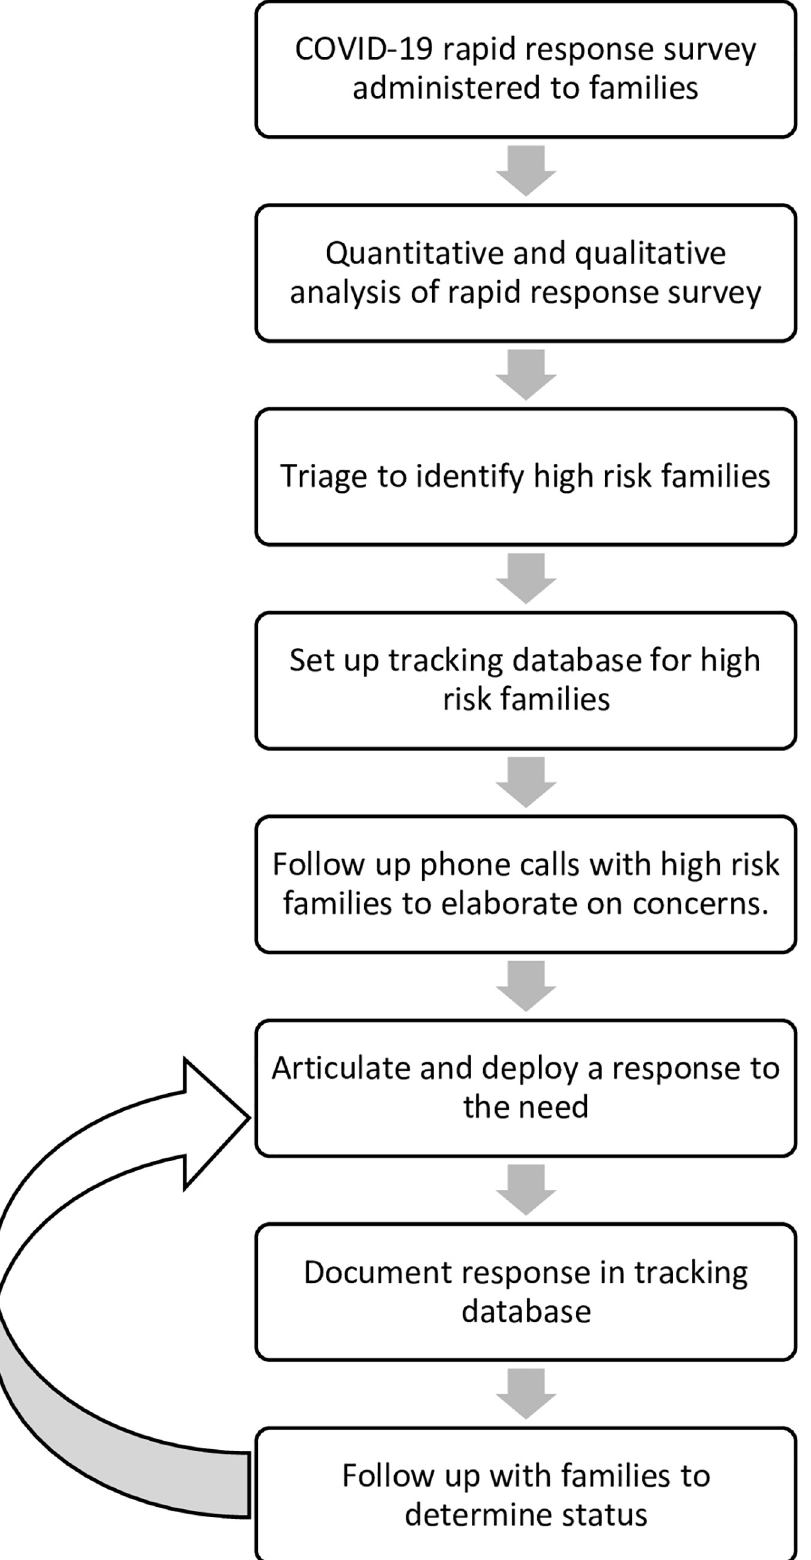
Fig 1. Flowchart of triage and response to need for high risk families, n = 71. https://doi.org/10.1371/journal.pone.0240009.g001 PLOS ONE | https://doi.org/10.1371/journal.pone.0240009 October 1,